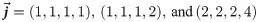
Statistics corresponding to conditions with j→=(1,1,1,1),(1,1,1,2),and(2,2,2,4).